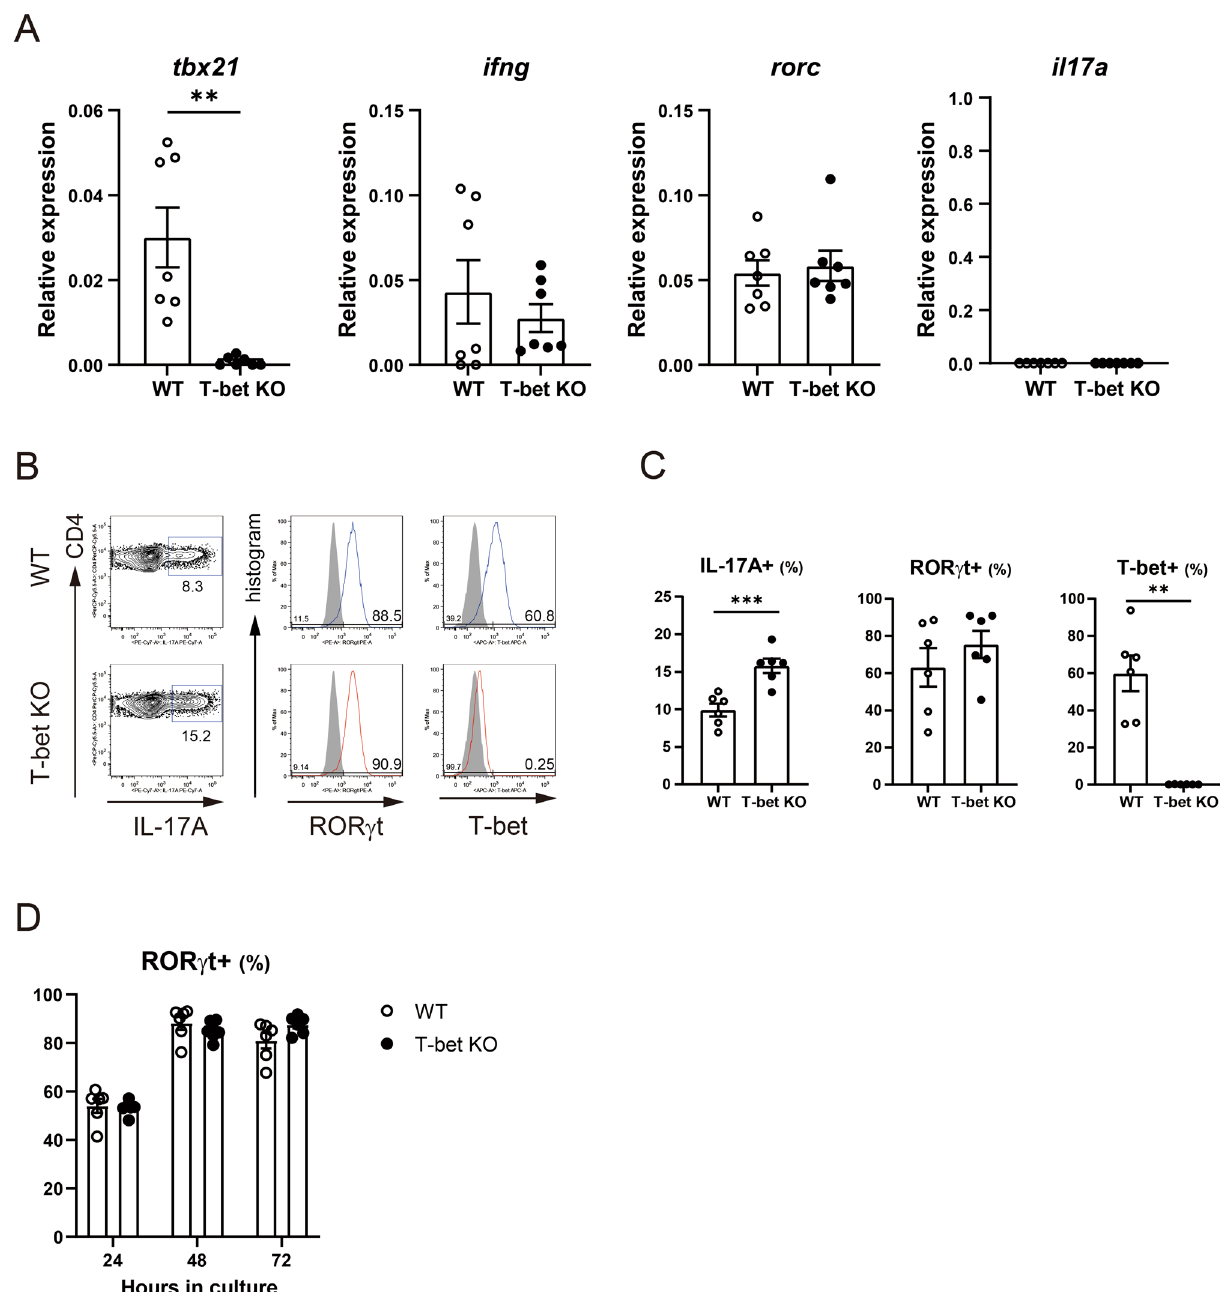
Figure 4. T-bet suppressed Th17 differentiation in vitro. Naïve CD4 + T cells from WT mice (n = 6–7) and T-bet KO mice (n = 6–7) were isolated. ( A ) Gene expression levels were analyzed using qRT-PCR. ( B – D ) Naïve CD4 + T cells were cultured under Th17 polarizing conditions and the percentage of IL-17A + cells, RORγt + cells, and T-bet + cells was analyzed using FACS. Data are presented as mean ± SEM. ( A , C , D ) was generated using GraphPad Prism 9 (version 9.1.2, https:// www. graph pad. com/ scien tific- softw are/ prism/), and ( B ) were generated using FlowJo (version 8.8.7, https:// www. flowjo. com/). Statistical tests: Welch’s t test ( A , C ). (** P < 0.01, *** P < cantly higher than that of T-bet fl/fl mice ( P = 0.02) (Fig. 5A,B). FACS analysis of infiltrating cells into the arthritic joints revealed that RORγt expression ( P = 0.01) and IL-17A production ( P = 0.02) was significantly increased in T-bet-deficient CD4 + T cells of cKO mice in comparison with T-bet fl/fl mice in which T-bet was expressed 51 ± 7.5% of CD4 + T cells (Fig. 5C,D). These results indicate that T-bet in CD4 + T cells is critical for the regula- tion of arthritogenic Th17 cells.